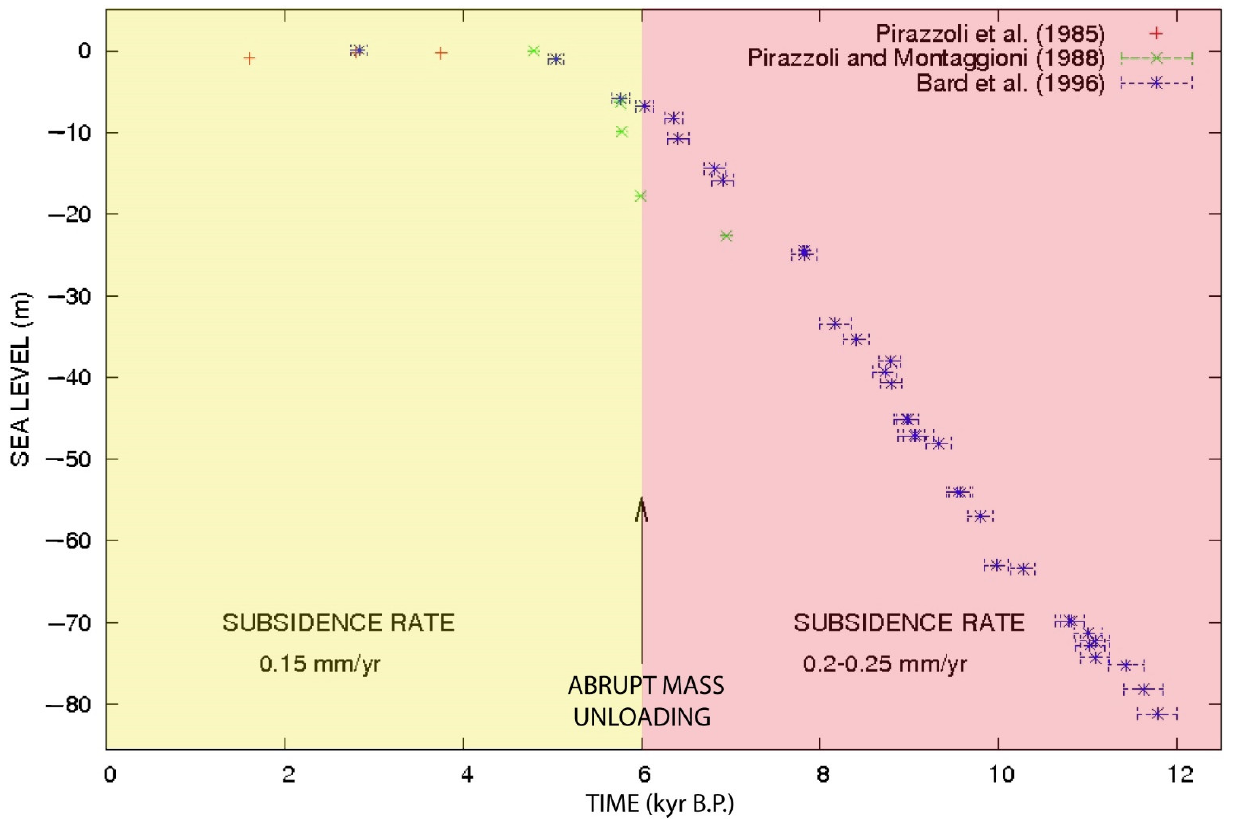
Figure 9. Sea level and subsidence rates in Tahiti. Sea-level variations and subsidence rates were estimated by [24,27,45] on one hand and [25] on the other hand. For Bard et al., (1996) [25] only samples dated by 14 C are represented for clarity.